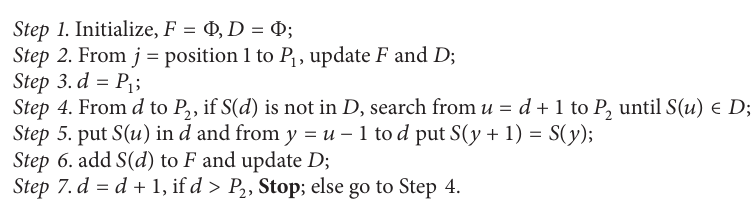
Algorithm 3: Repair strategy for interchange